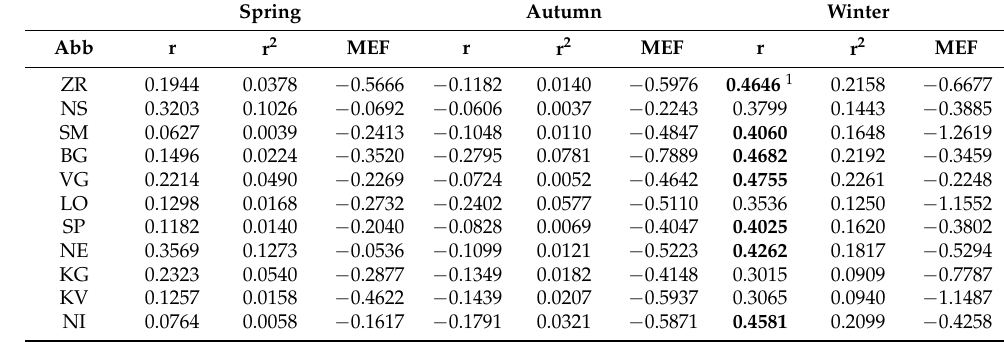
Table 9. Seasonal results from linear regression models for